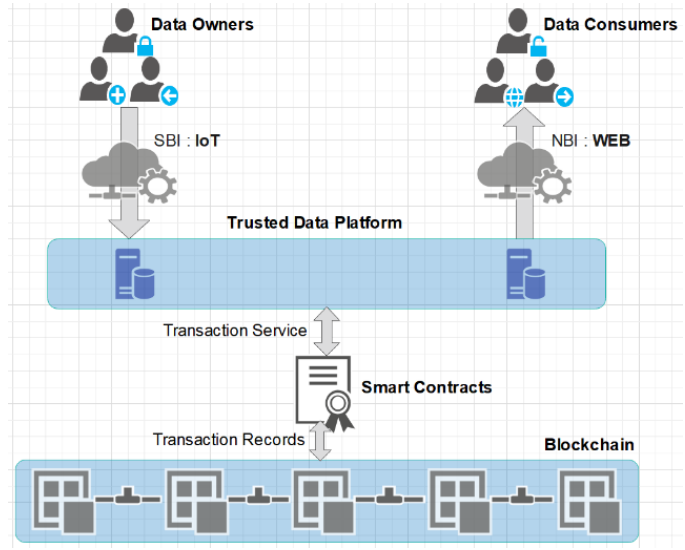
Figure 1. Blockchain-based